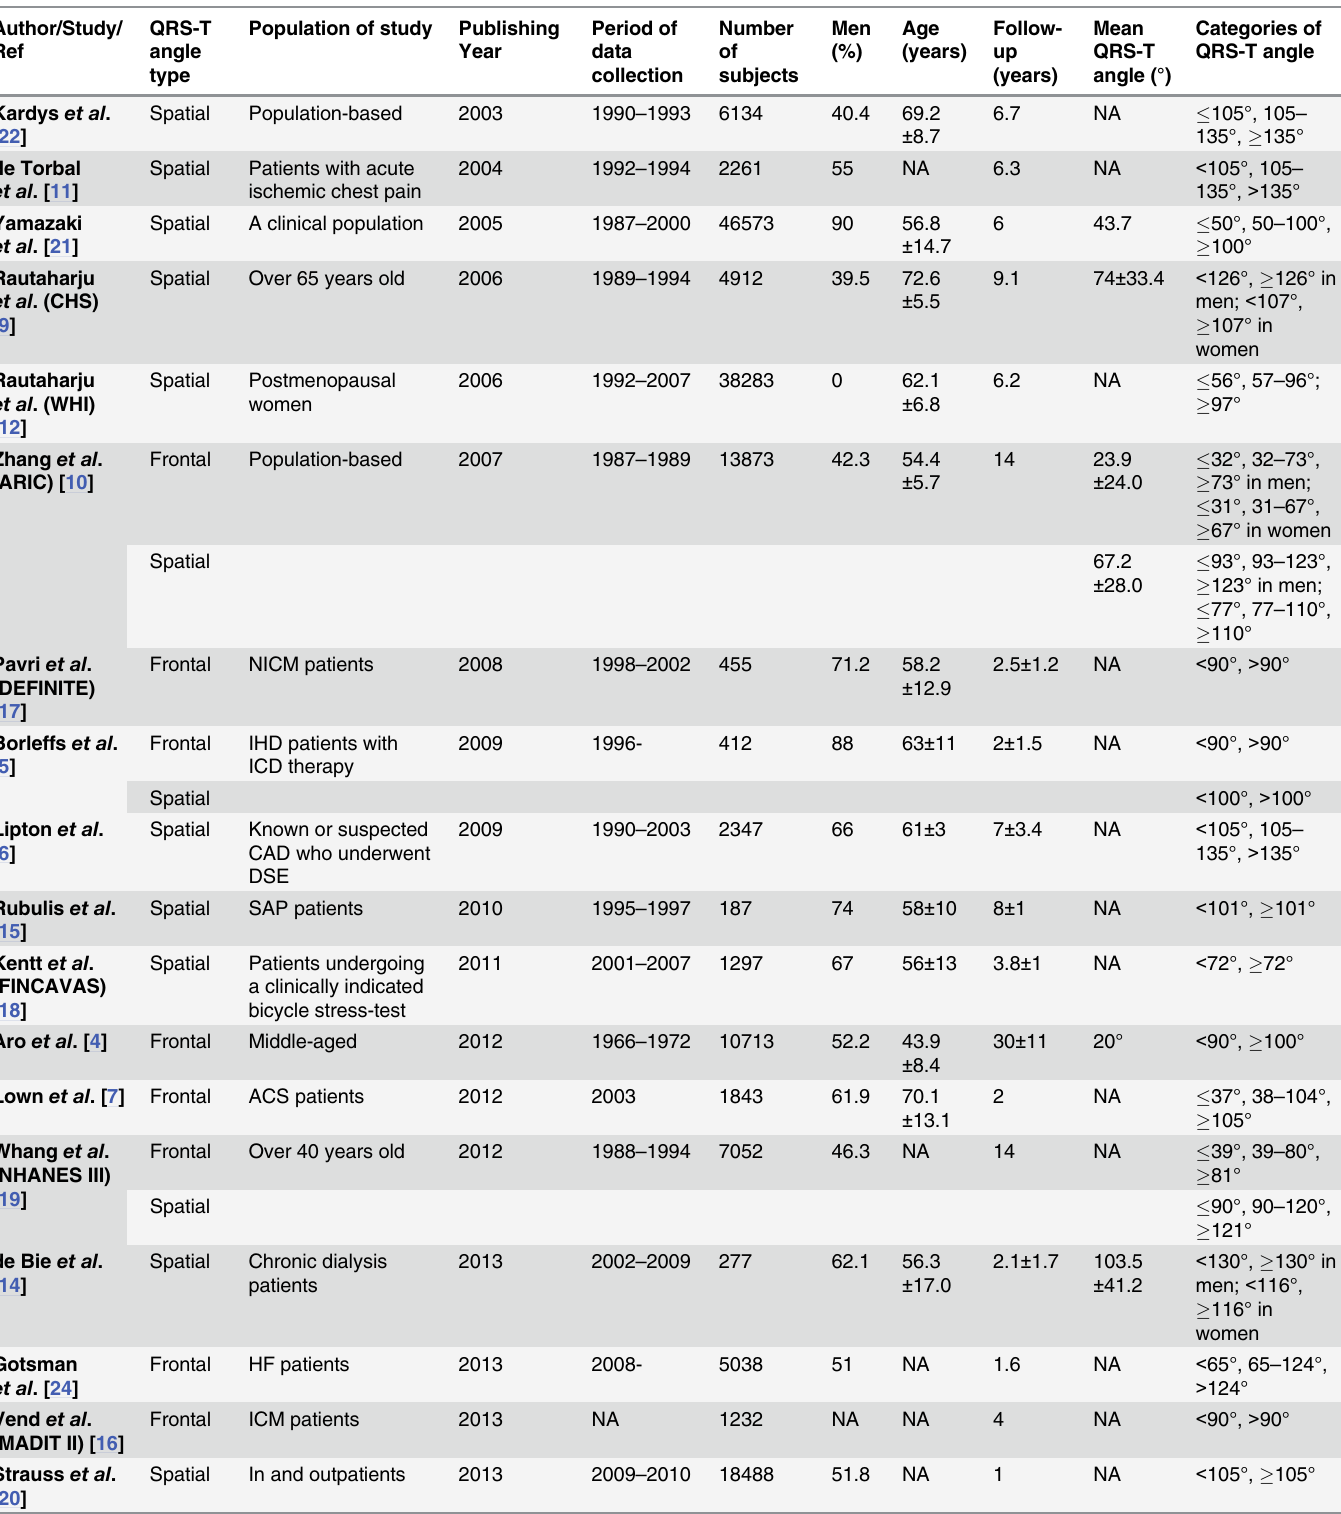
Table 1. Characteristics of the studies included in the